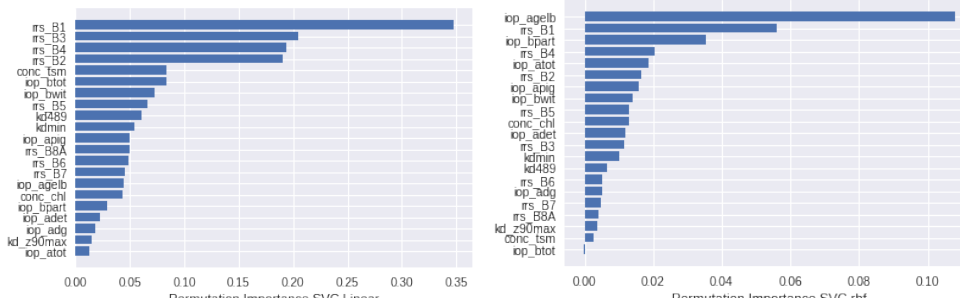
Figure A3. Feature importance derived from